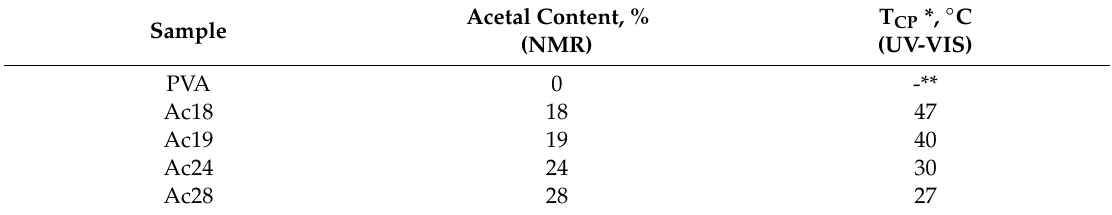
Figure 1. ( a ) Schematic presentation of acetalization reaction of PVA; ( b ) 1 H NMR spectrum of copolymer AC18 (solvent DMSO-d 6 ). Table 1. Acetal content and cloud point (T CP ) of modified PVA copolymers.